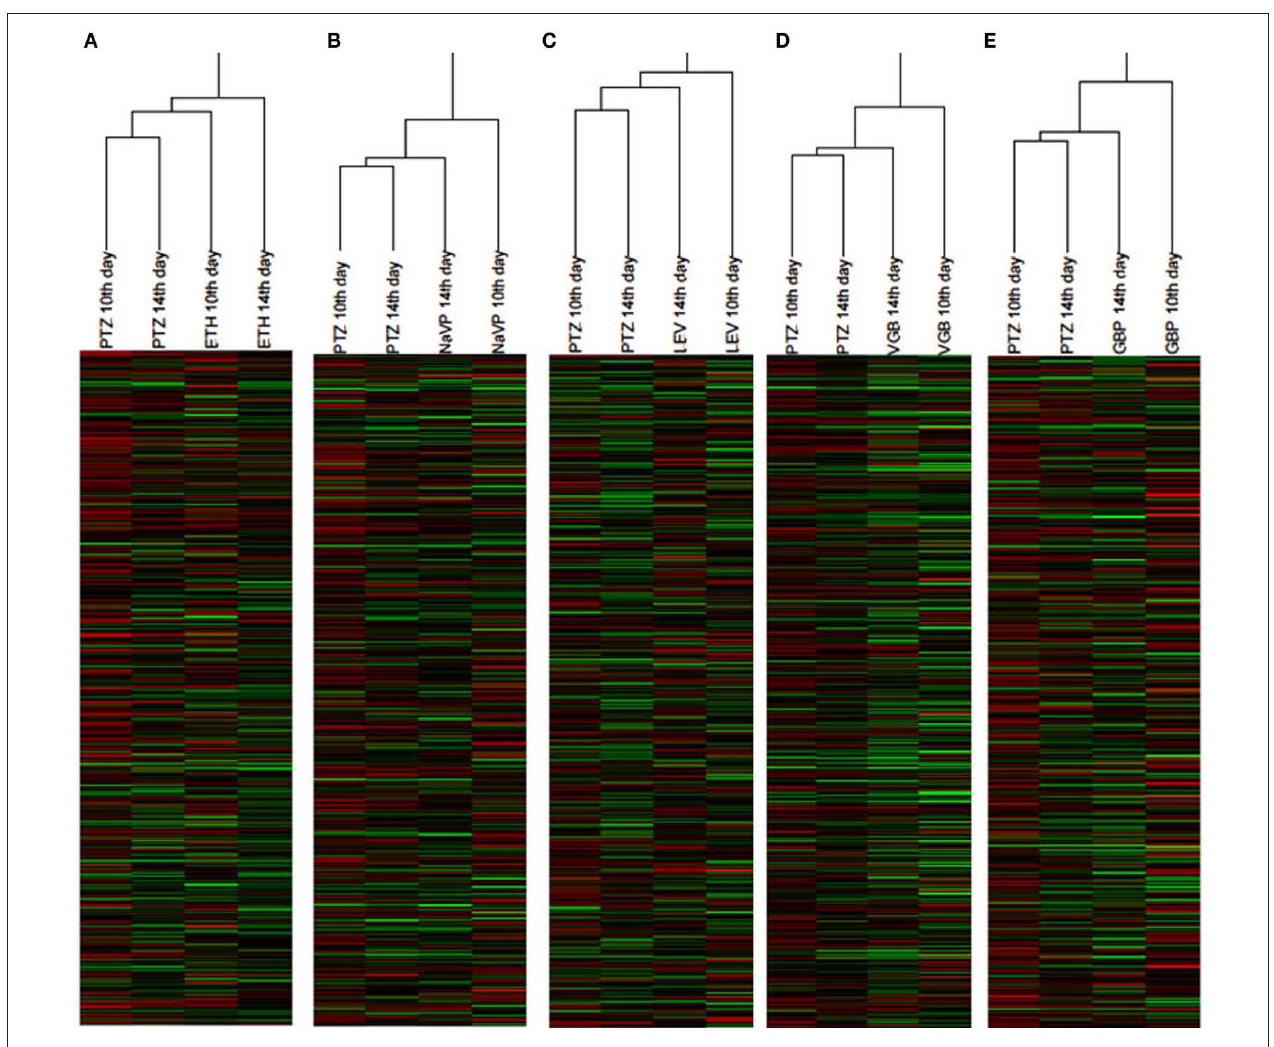
Note clear separation of the two groups. The AED untreated group is indicated by PTZ, and the AED treated groups by AED abbreviation. Jaccard similarity metric and average linkage methods were used for